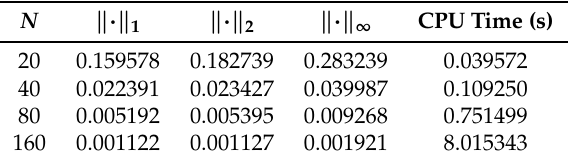
Table 3. Error table using FEM for the approximate solution p ( v , t ) graphically represented in Figure 3, at a final time t = 0.0408 with the finest grid being N ∗ = 320.